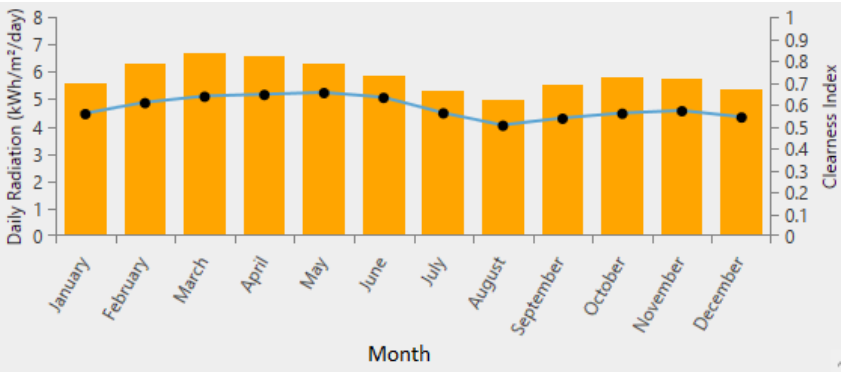
Figure 7. The monthly daily average solar radiation and clearness index for Djoundé .